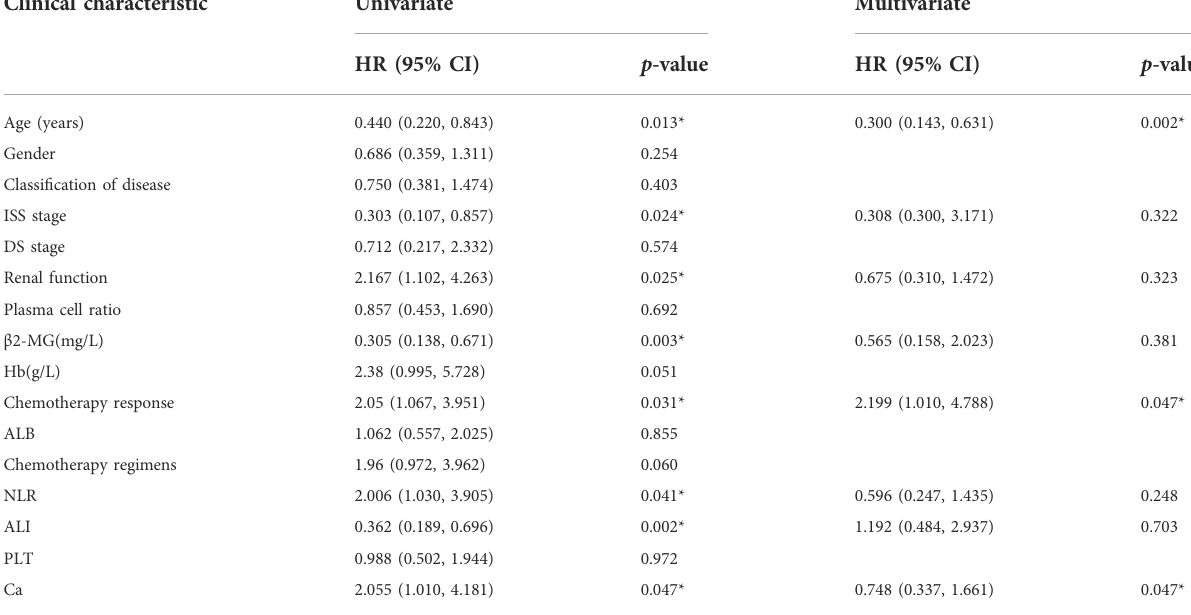
TABLE 1 Cox regression analysis of predictive factors for overall survival in patients with MM ( n =